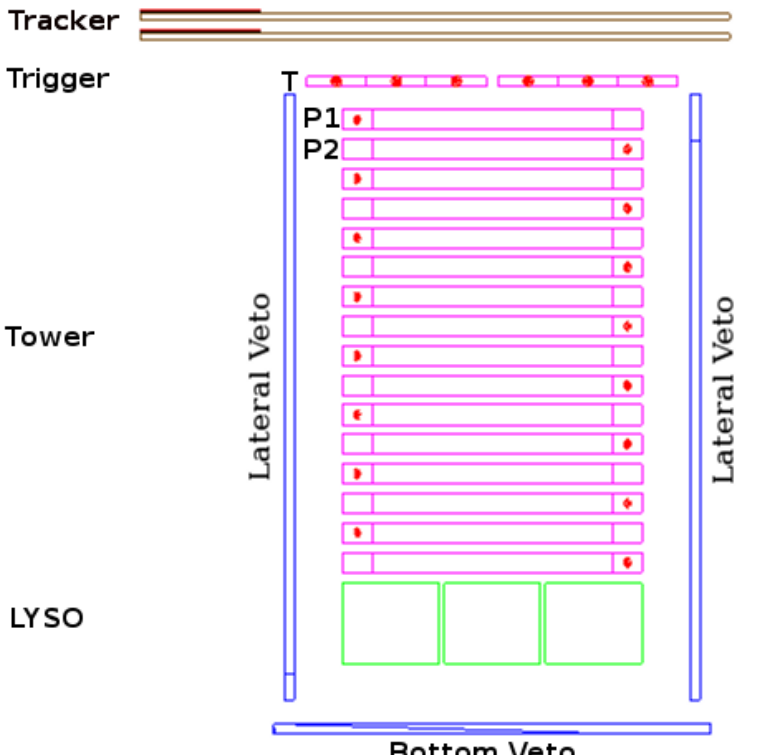
Figure 1. Schematic of the HEPD detector. All mechanical structures (as well as the lateral VETO plane located in the front) have been removed from the figure for visualization